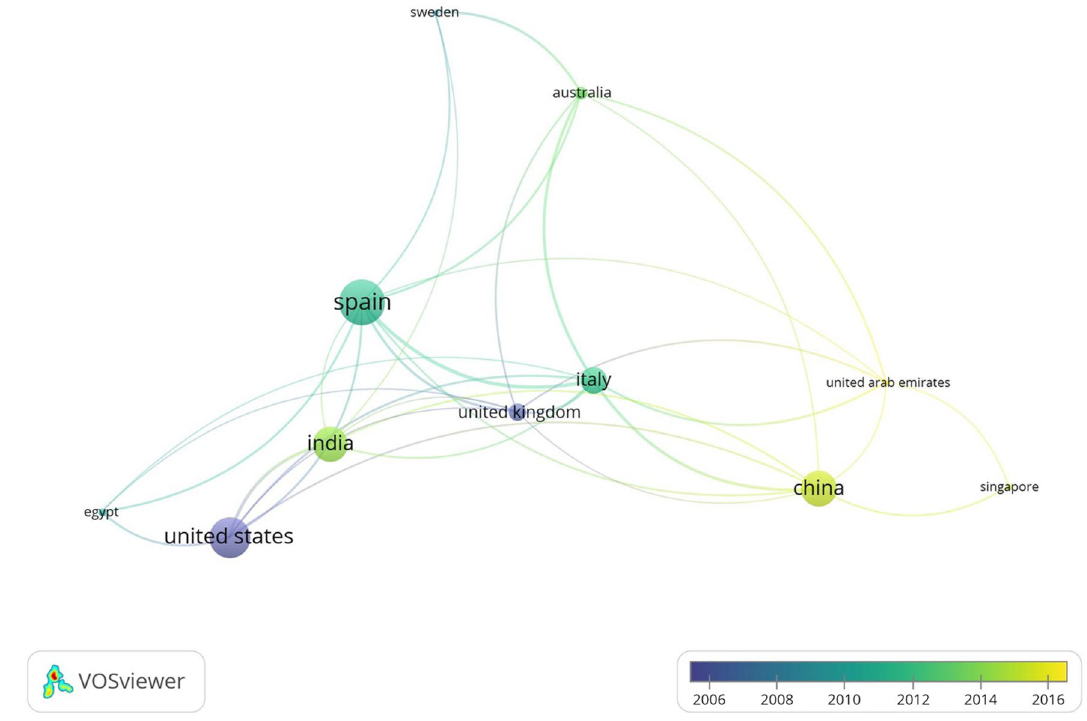
Fig. 5 Overlay visualization of countries included in top 5 ranking based on number of documents